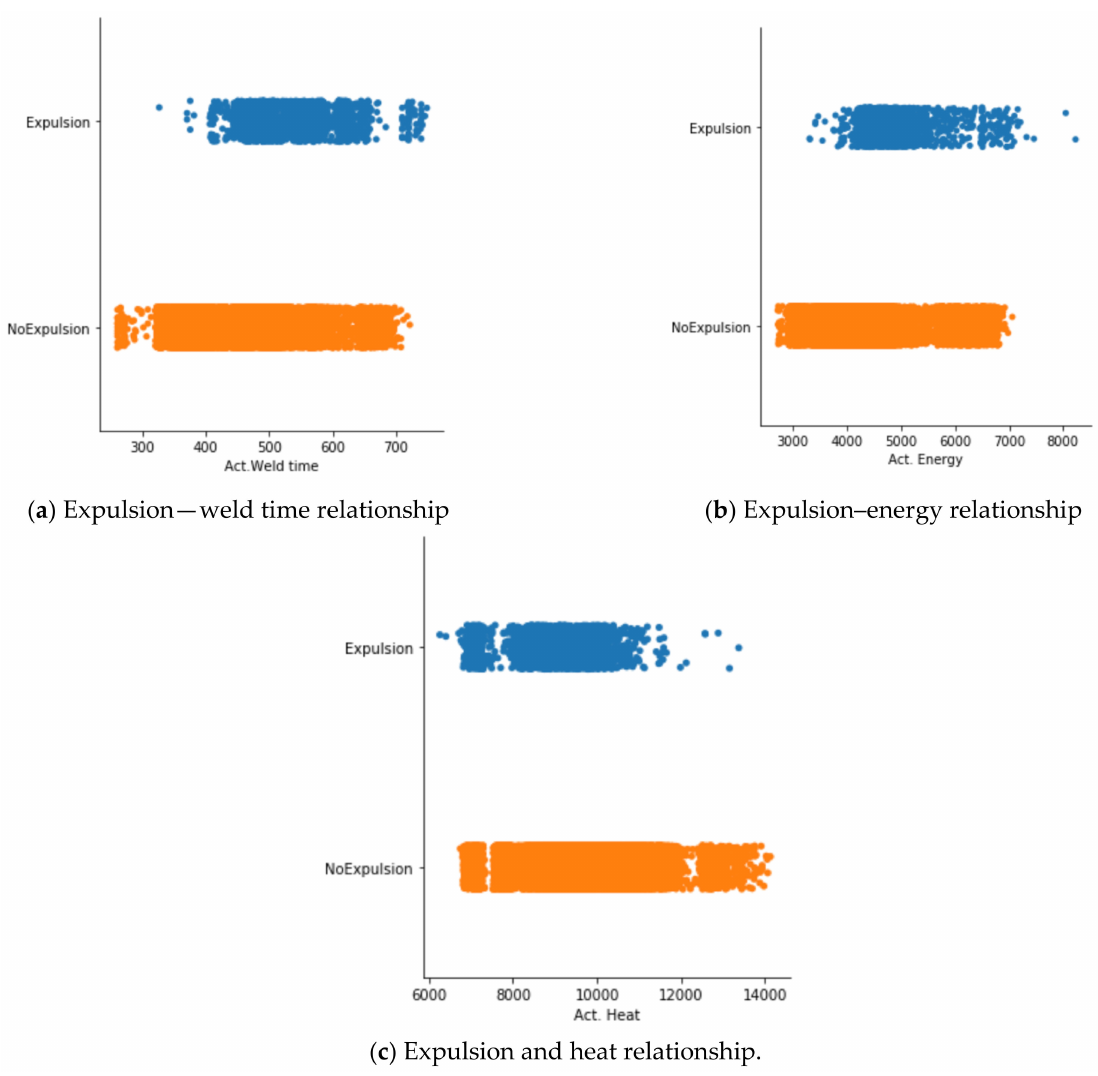
Figure 6. Expulsion’s Relationship with other